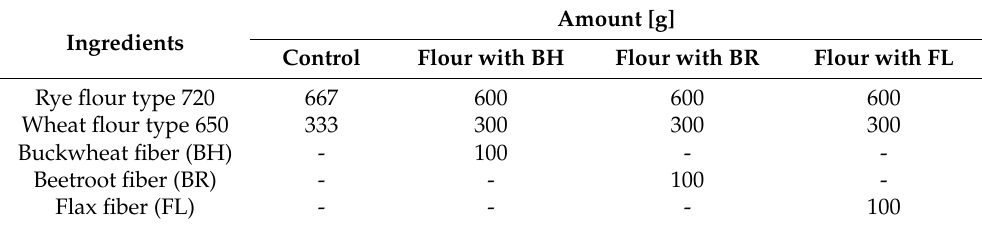
Table 1. Recipes of mixes based on 1 kg of